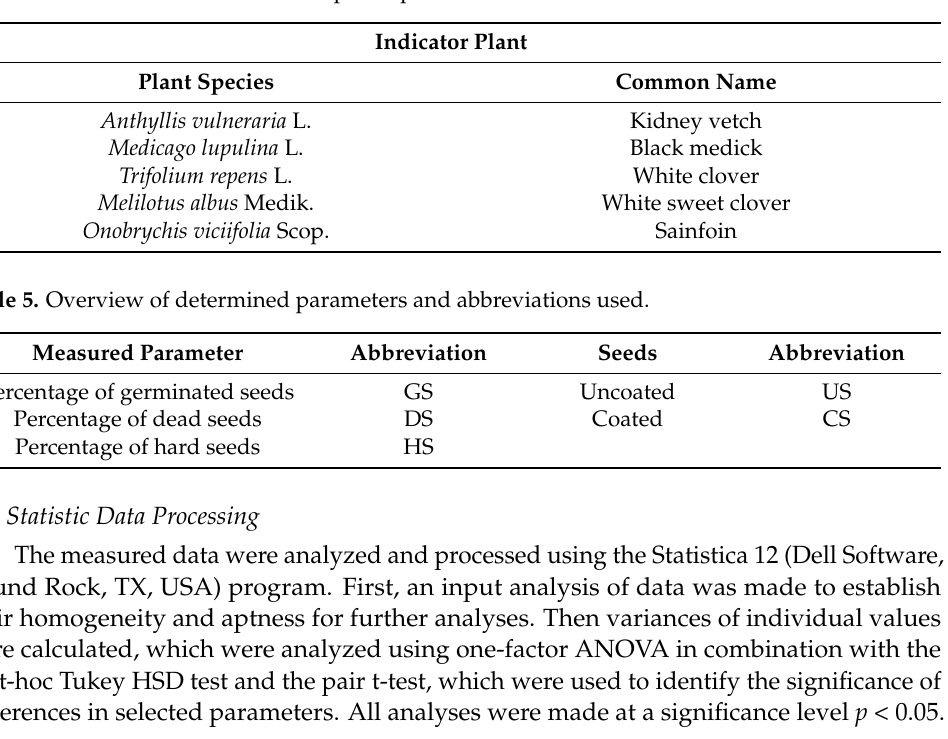
Table 4. Overview of assessed model plant species.